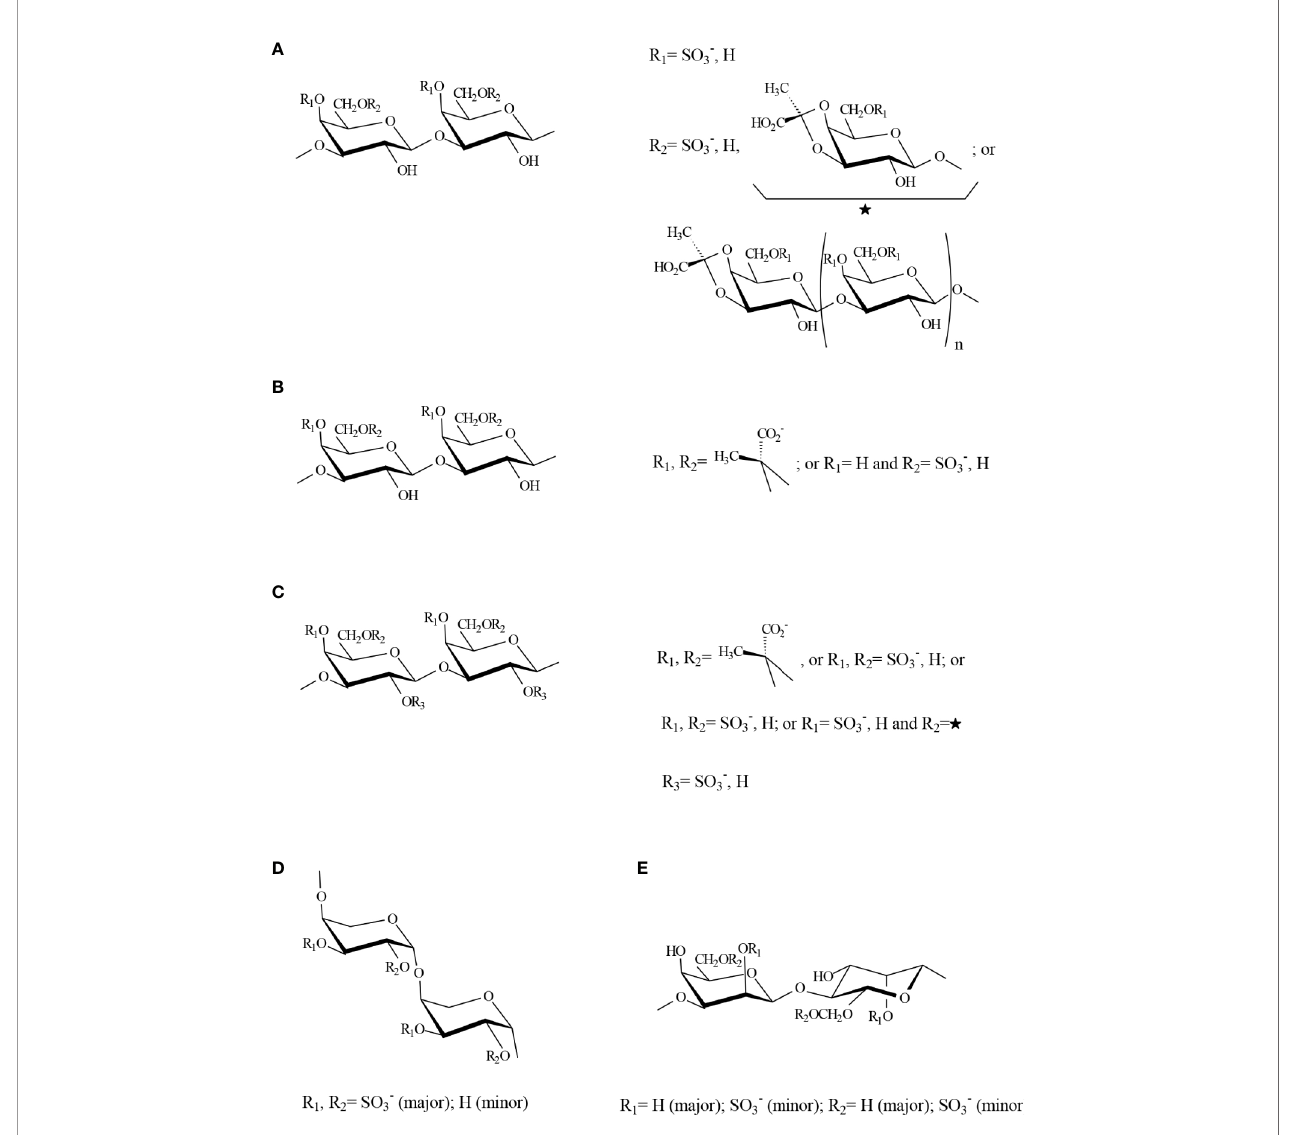
FIGURE 4 | Possible structure for a fragment containing all the major structural features of sulfated polysaccharides (A) A galactan from Codium species, (B) An homogeneous fraction from Bryopsis plumosa , (C) Galactans from species in the Halimedaceae, (D) Pyranosic arabinan from Codium species, (E) Mannan from Codium species. Structures were proposed by the authors of this review based on the major components detected by Bilan et al., 2007; Estevez et al., 2009; Ciancia et al., 2012; Ferna ́ ndez et al., 2012; Ferna ́ ndez et al., 2013; Arata et al., 2015; Ferna ́ ndez et al.,